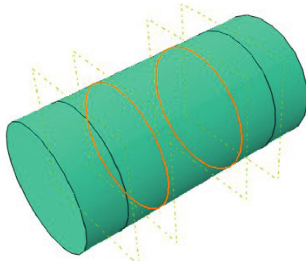
Figure 12: FEM of the lead core.